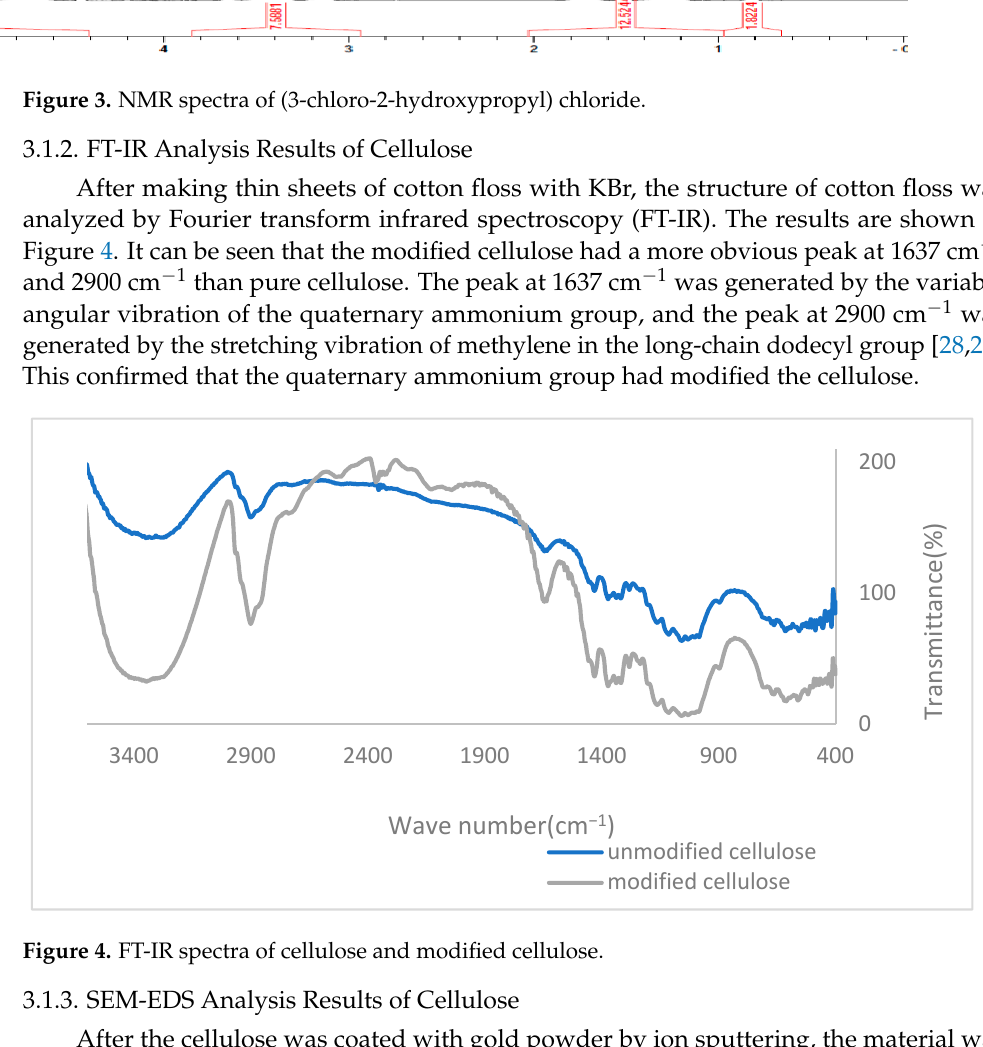
Figure 4. FT-IR spectra of cellulose and modified cellulose.